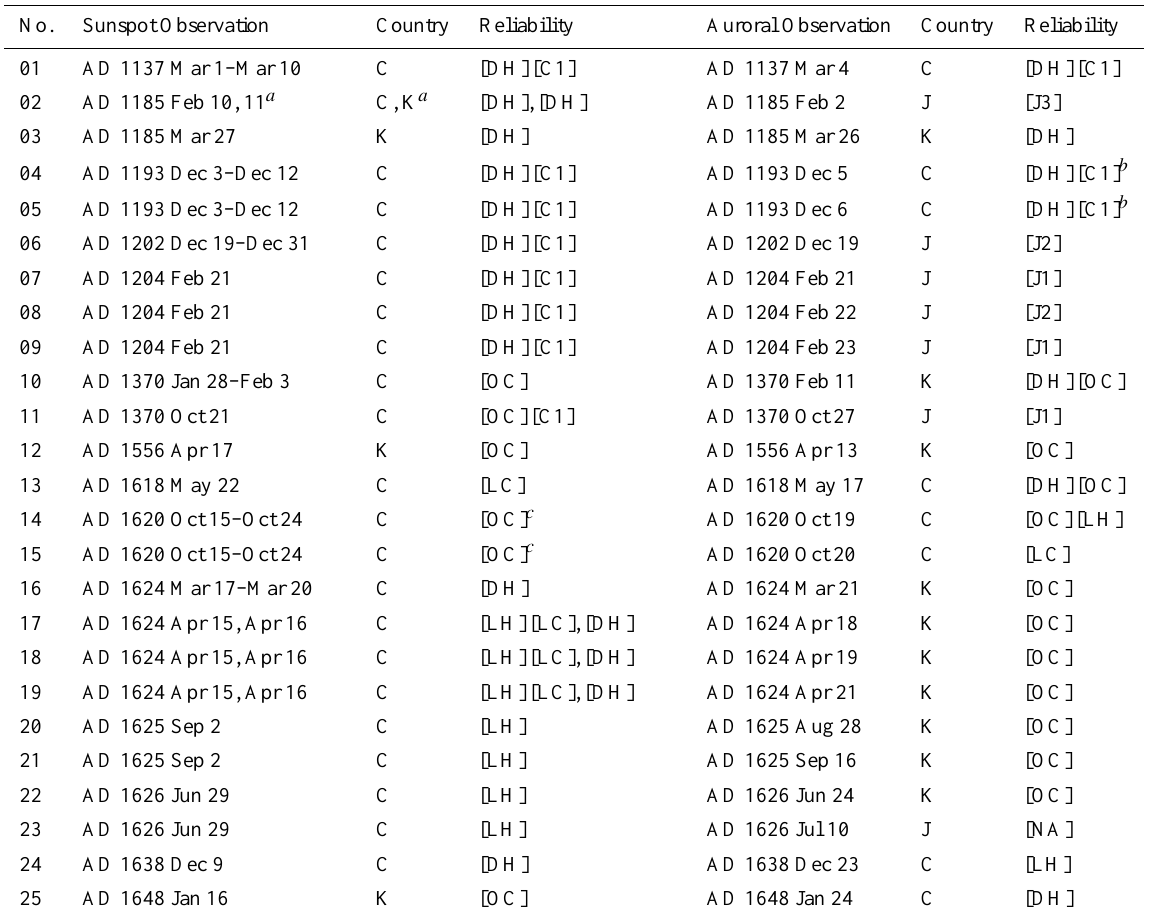
Table 1. Chronological list of “approximate coincidences” between oriental sunspot and auroral observations, derived from the sunspot and auroral databases (Sect. 3) using the condition − 8 ≤ T ≤+ 15 to define historical geomagnetic storms (Sect. 4.2). Dates before AD 1582 October 5 are in the Julian calendar, whereas subsequent dates are in the Gregorian calendar. The country of origin of each observation, as recorded in the oriental histories, is denoted by a capital letter: C=China; J=Japan; and K=Korea. The “literary” reliabilities of the observations are classified in terms of the historical sources as follows: [DH]=a record of high reliability from a dynastic history ; [OC]=a record of high reliability from an official chronicle ; [LH]=a record of lesser reliability from a local history ; [LC]=a record of lesser reliability from a late compilation (Appendix A). The “scientific” reliabilities of the observations are defined as follows: 1=certain; 2=very probable; 3=probable; 4=doubtful; and 5=unlikely (Appendix A). The abbreviation [NA] (=not available) is used to qualify the single Japanese auroral record (AD 1626 July 10) for which no reliability classification is available (Appendix R). Notes. The superscript a signifies that the sunspot observation on AD 1185 February 10 was recorded in China, whereas the sunspot observation on February 11 (which does not satisfy the selection criterion defined in Sect. 4.2) was recorded in Korea; the superscript b signifies that the “scientific” reliability is borderline between [C1] and [C2]; and the superscript c signifies that the corresponding oriental record must be treated with extra caution, despite its apparent reliability, because it is based on a retrospective entry in an official chronicle (see Appendix